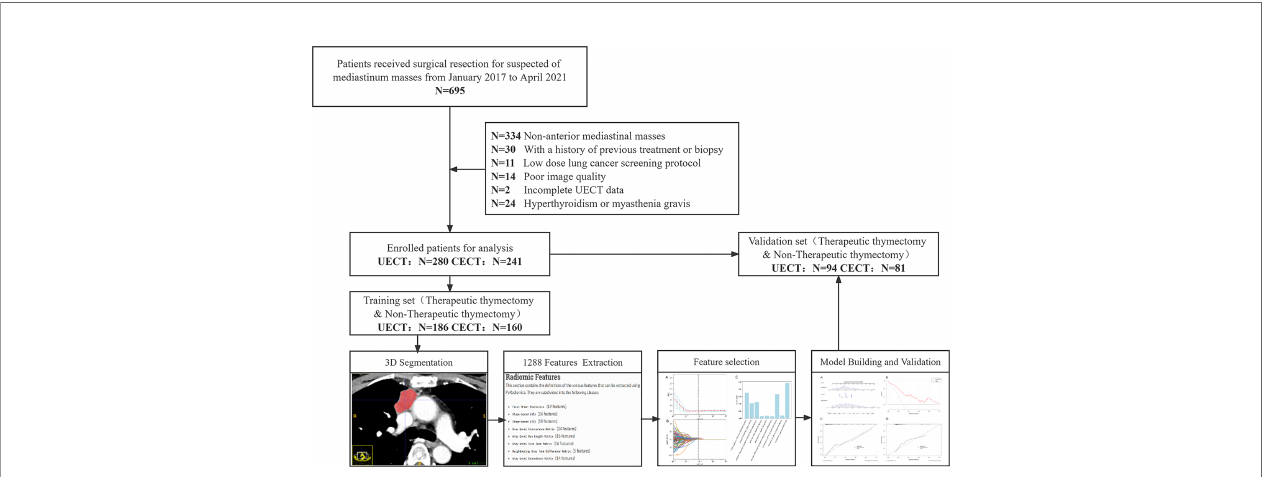
FIGURE 1 | Flowchart of the patient recruitment pathway. The fl owchart shows how the study population has been selected and its retrospective manner. N , number; UECT, unenhanced computed tomography; CECT, contrast-enhanced computed